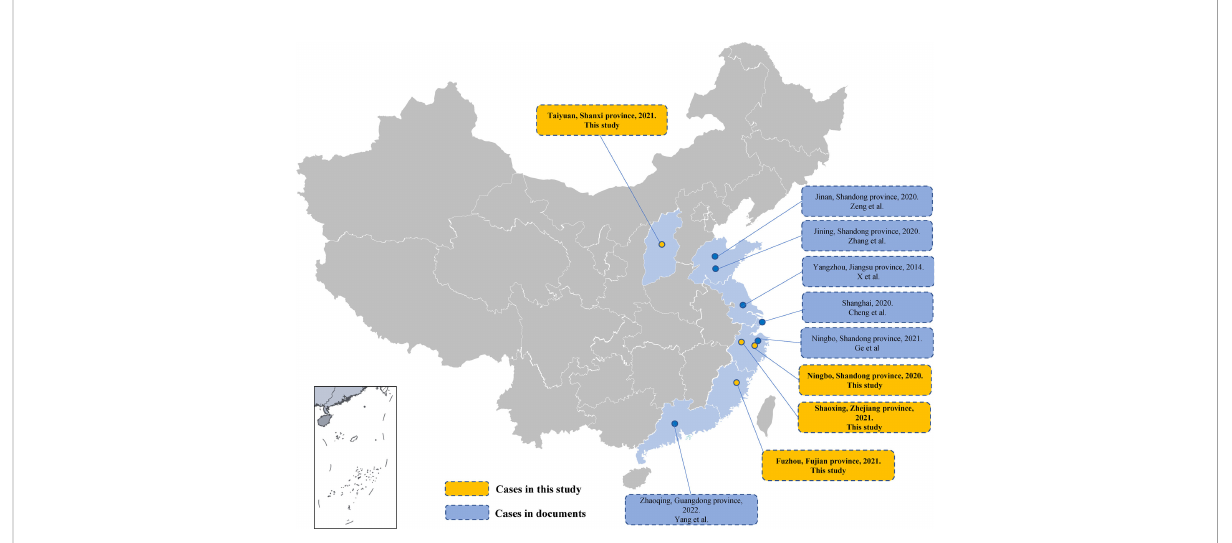
FIGURE 1 Human infection by Rickettsia felis in mainland China. Provinces where human cases of R. felis infection have been found are labeled in light blue. Curved lines indicate provincial